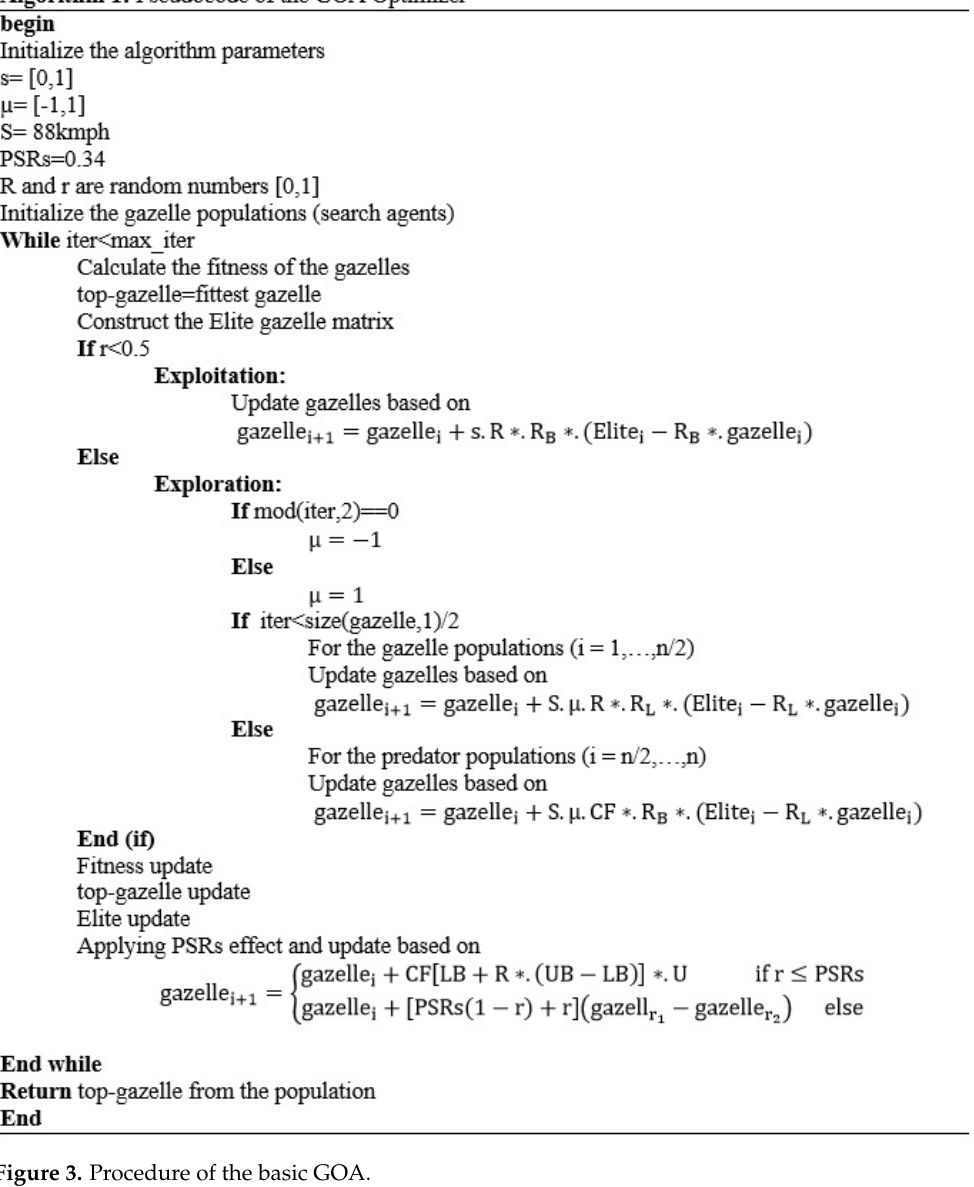
Figure 3. Procedure of the basic